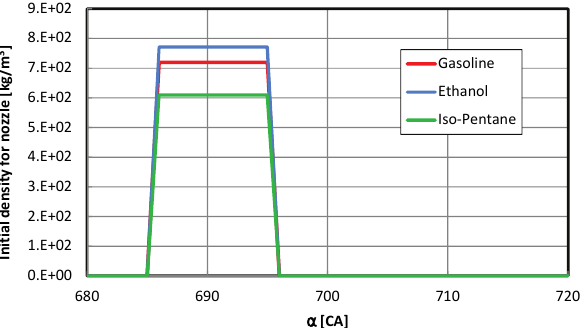
Fig. 8. The effect of the initial fuel droplet density during outflow from the injector on the fuel type during injection